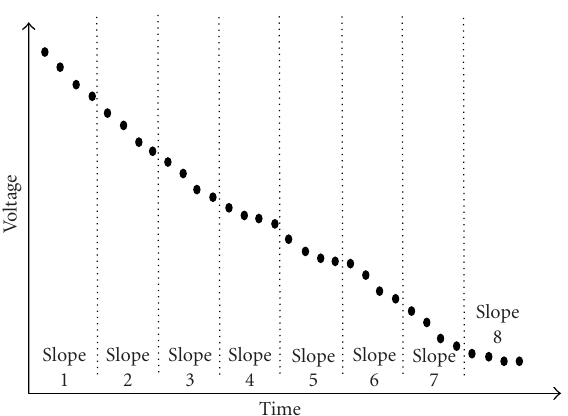
Figure 4: Least squares fitting of sub-ramps for 32-sample ramp over every 4 samples of a